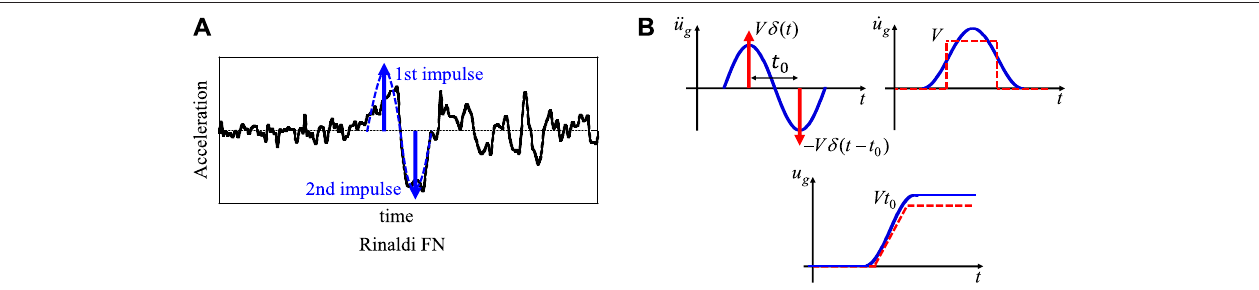
FIGURE 1| Transformation of recorded ground motion into aone-cycle sine wave and double impulse, (A) Example ofRinaldiStation FN componentduring 1994 Northridge earthquake and its modeling into a one-cycle sine wave and double impulse, (B) Velocity and displacement properties of a one-cycle sine wave and double impulse.